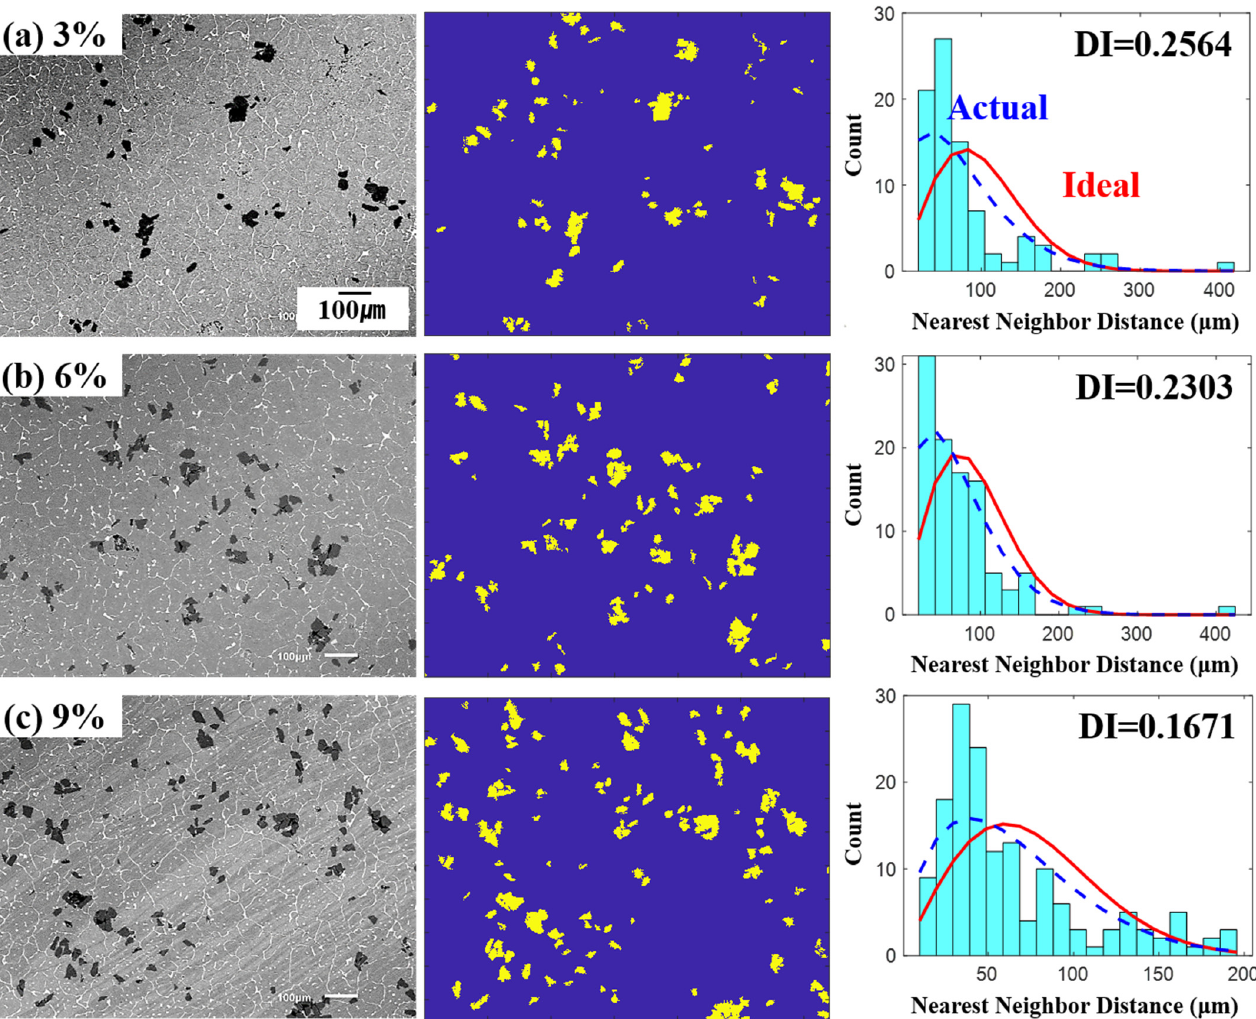
Figure 5. Degree of particle dispersion by the SC process: ( a ) 3 vol.%, ( b ) 6 vol.%, and ( c ) 9 vol.%.